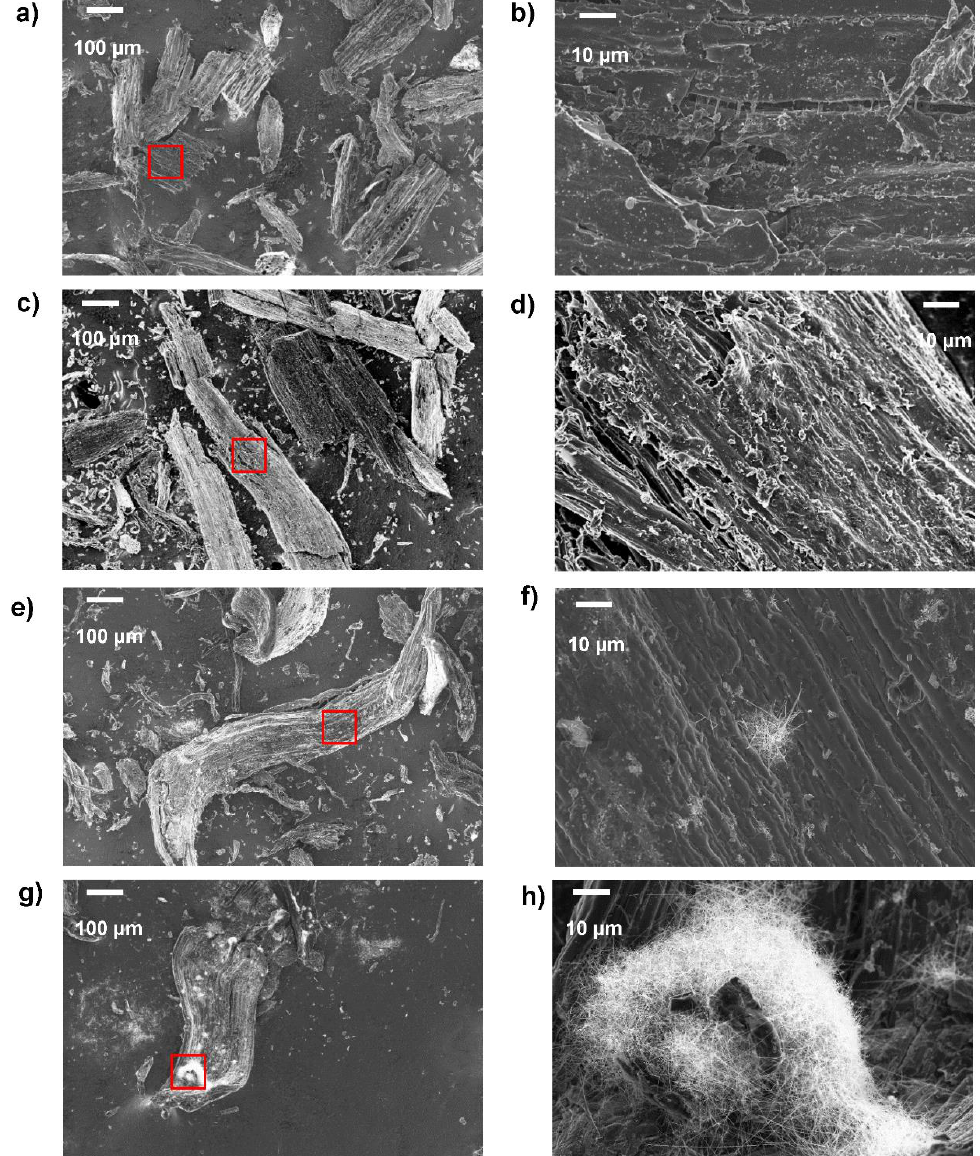
Figure 5. SEM images for hard carbons obtained at 1400 °C derived from ( a , b ) pine, ( c , d ) beechwood, ( e , f ) miscanthus, and ( g , h ) wheat straw.